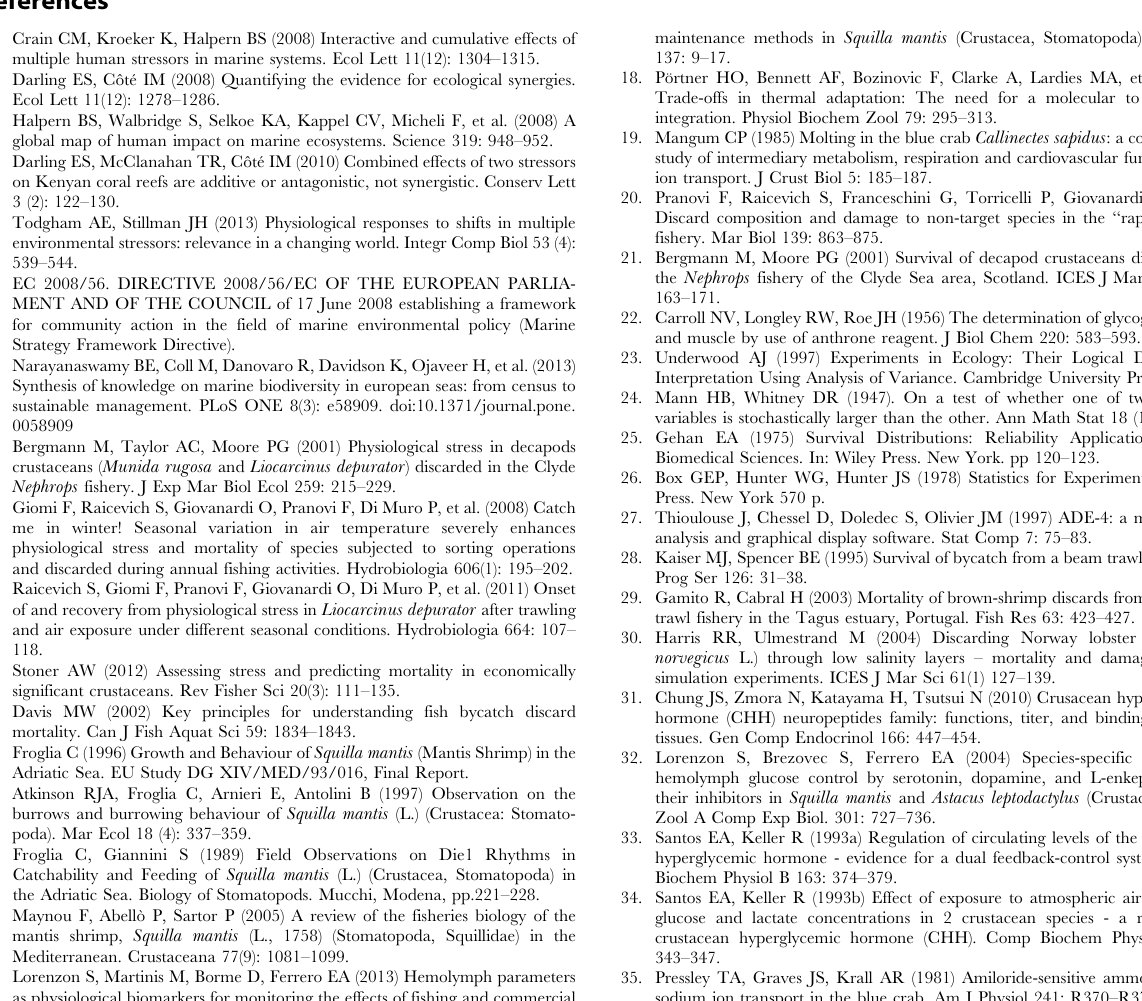
Table S3 Experimental values observed in Squilla mantis at different treatment levels. Organisms in aquaria in lab experiment (C); organisms at the end of trawling in field experiments (ET); trawled organisms in field experiments after exposure to air (0.5 hours, EEA); organisms after 2 and 24 hours recovery in water in the field experiments. Values are expressed as a mean 6 standard error (n =6 individuals for each treatment). Significant pairwise comparisons are highlighted between treat- ments and are shown at the top with bold characters (Mann- Whitney U test, p , 0.05). Table S4 Exposure to air lab experiment (0–2 hours): 2- Way ANCOVA results. Significant effects are highlighted in bold. Table S5 Exposure to air field experiment (0–2 hours): 2-Way ANCOVA results. Significant effects are highlighted in bold. Table S6 Early phase (0–2 hours) of the recovery process: 2-Way ANCOVA results. Significant effects are highlighted in bold.